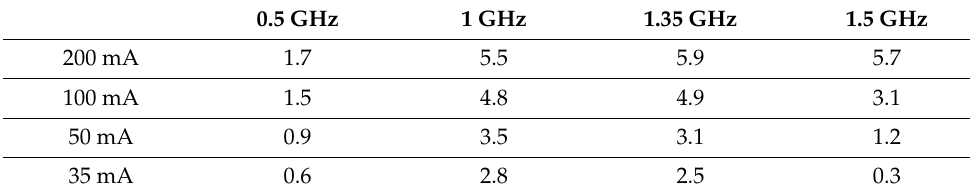
Figure 7. Radiation patterns for the fourth lamp configuration at different frequencies and discharge currents. The curve designations ( a – e ) correspond to those in Figure 4. Table 4. Antenna system directivity (dB) for the fourth lamp configuration.